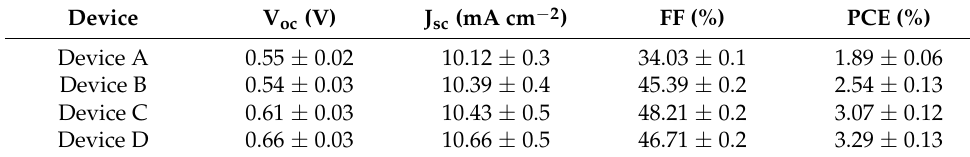
Table 1. The values of the four inherent parameters of the four